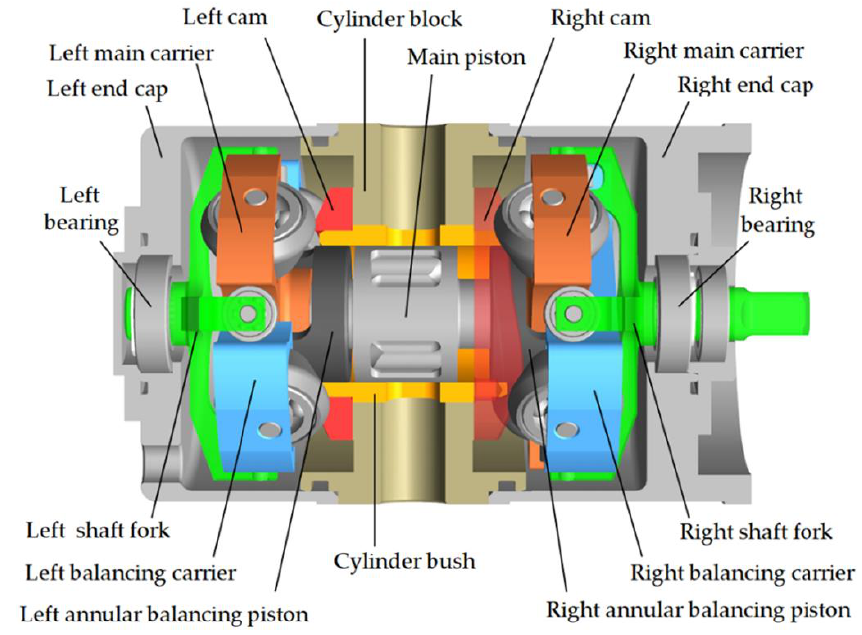
Figure 1. Schematic configuration of the 2D piston pump with balancing sets.